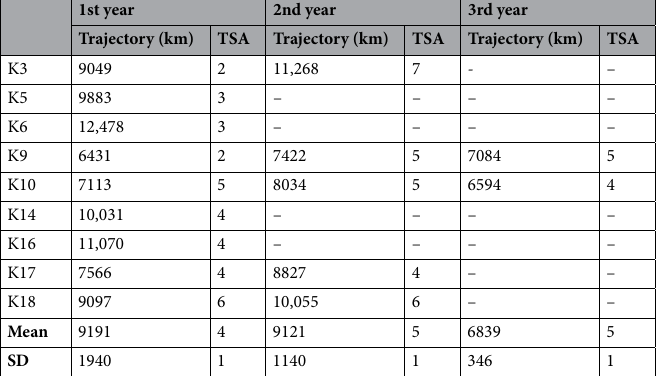
Table 3. Characteristics of the total distance traveled during a one year long modul. Only birds that survive for at least one year (from the date of tagging untill the 30. 06. following year) are included in the table.